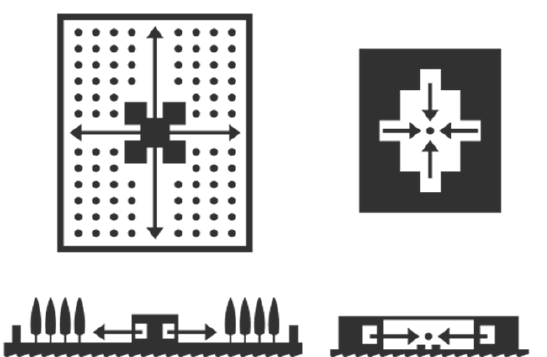
Figure 5. Two schemes of architectural gardens in the chor-bag form: “perimeter wall–garden–central pavilion” and “perimeter building–garden” [33].